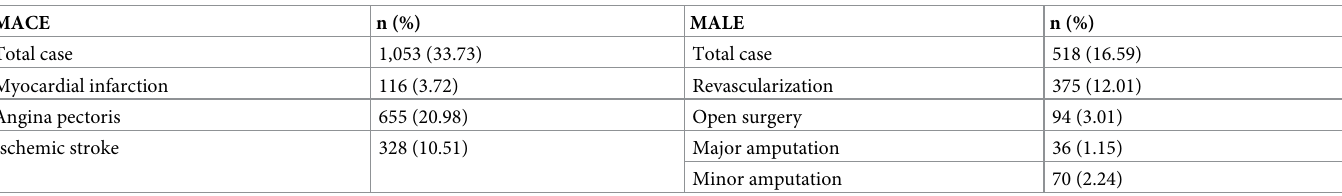
Table 3. MACE or MALE occurrence during the study period (n = 3,122).